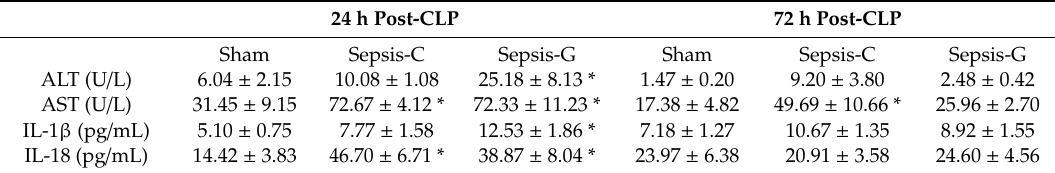
Table 2. Plasma liver function markers and interleukin (IL)-1 β and IL-18 levels among groups at di ff erent time